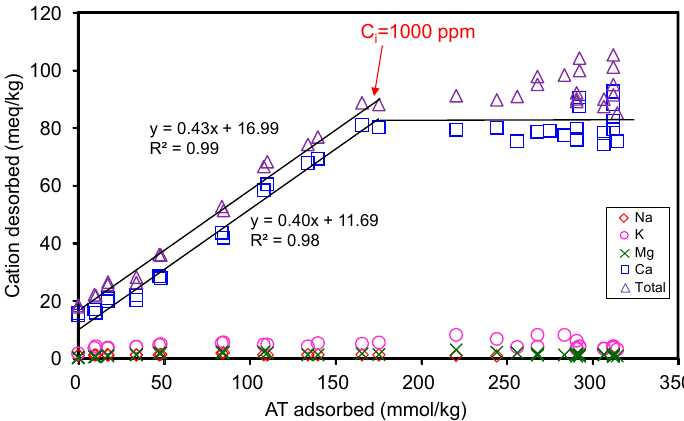
Figure 4. Desorption of metal cations from SAz-2 as affected by the amount of AT adsorption.